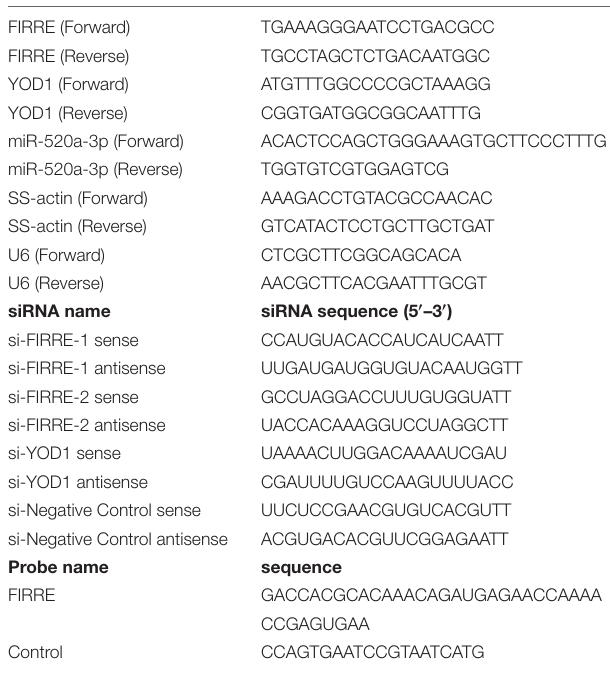
TABLE 1 | Information of the qRT-PCR